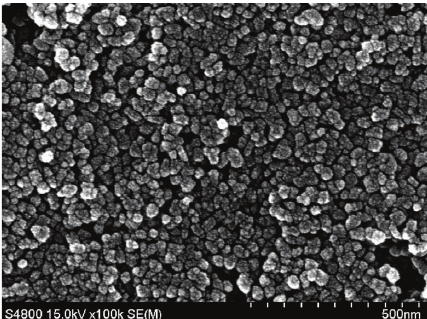
Figure 6: FE-SEM image of TiO 2 thin film.